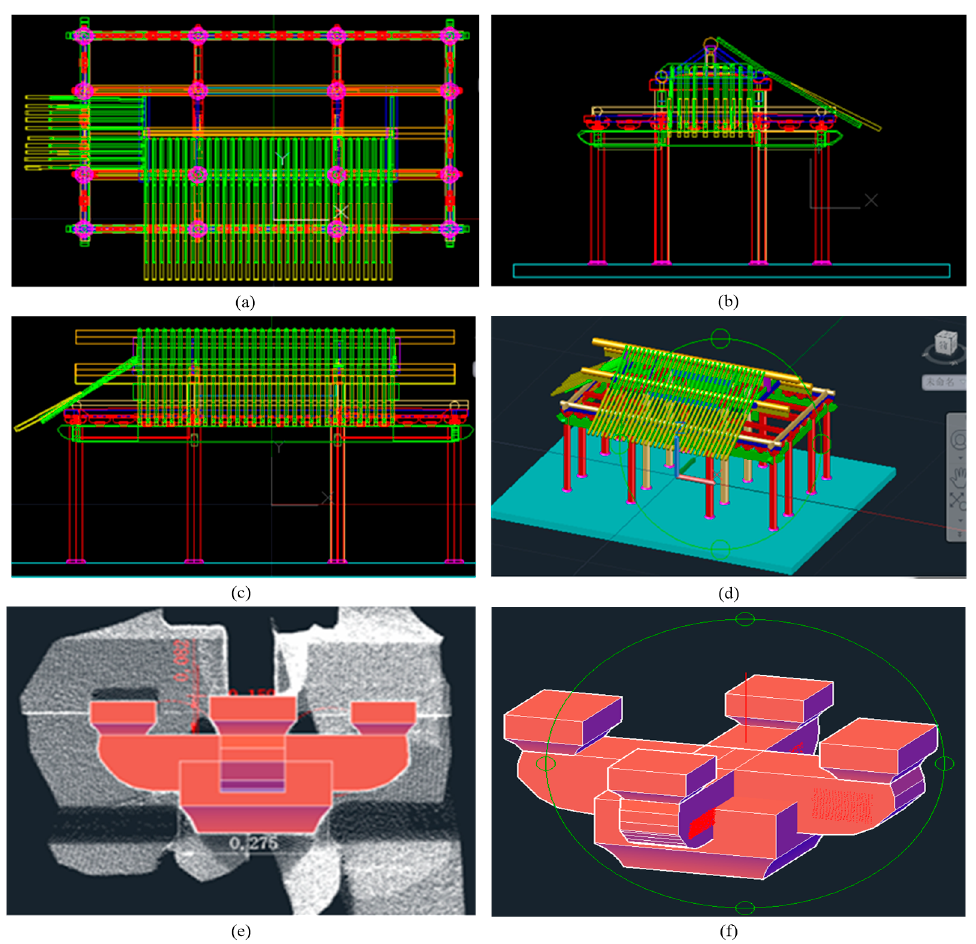
Figure 14. Reconstructive 3D modeling of the architecture. ( a ) Plan drawing of the building; ( b ) section drawing of the building; ( c ) facade drawing of the building; ( d ) reconstructive 3D model of the building; ( e ) architectural component modeling; ( f ) reconstructive 3D model of the component.